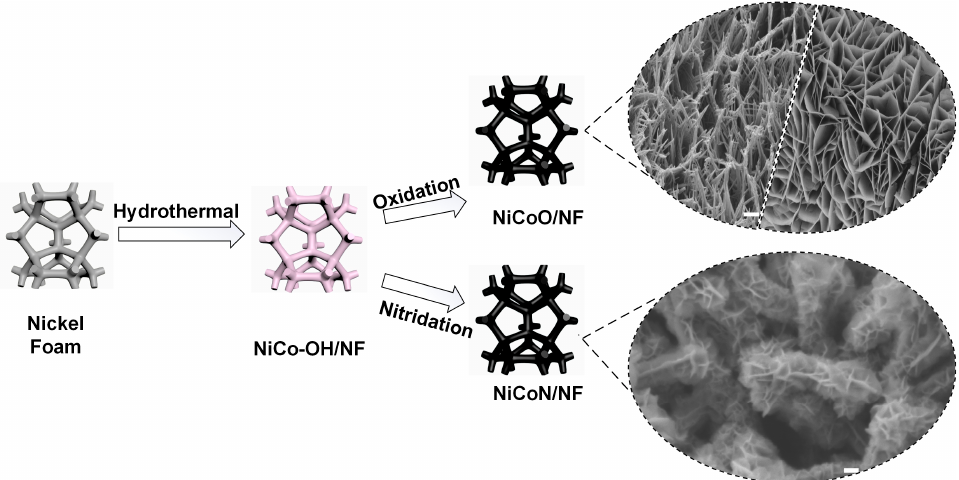
Figure 1. Schematic illustration of the synthesis process of the nickel-cobalt oxides and nitrides on nickel foams.